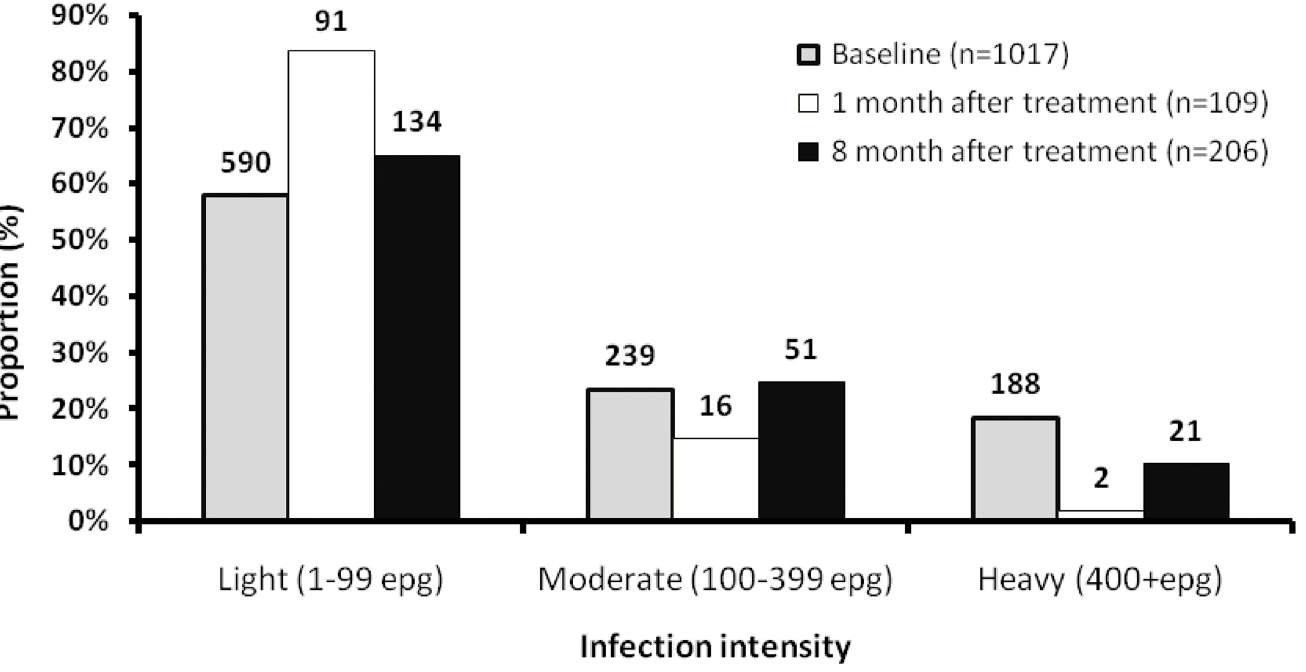
Fig 3. Overall distribution of Schistosoma mansoni infection intensity in preschool-age children at baseline, 1 month and 8 month after